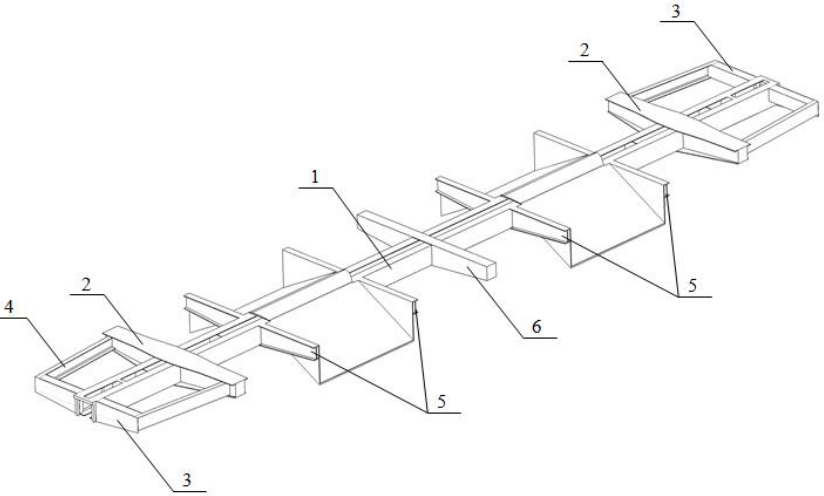
Figure 2. The frame of a two-section wagon: 1—center girder; 2—pivot beam; 3—end beam; 4—struts; 5—intermediate transverse beams; 6—medium beam.